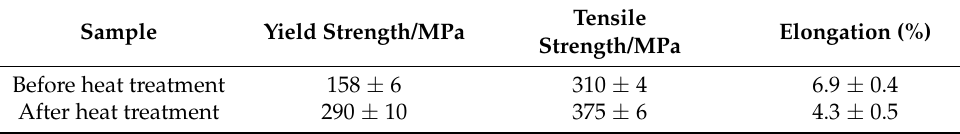
Table 3. Mechanical properties of non-heat-treated, die-cast aluminum alloy samples.